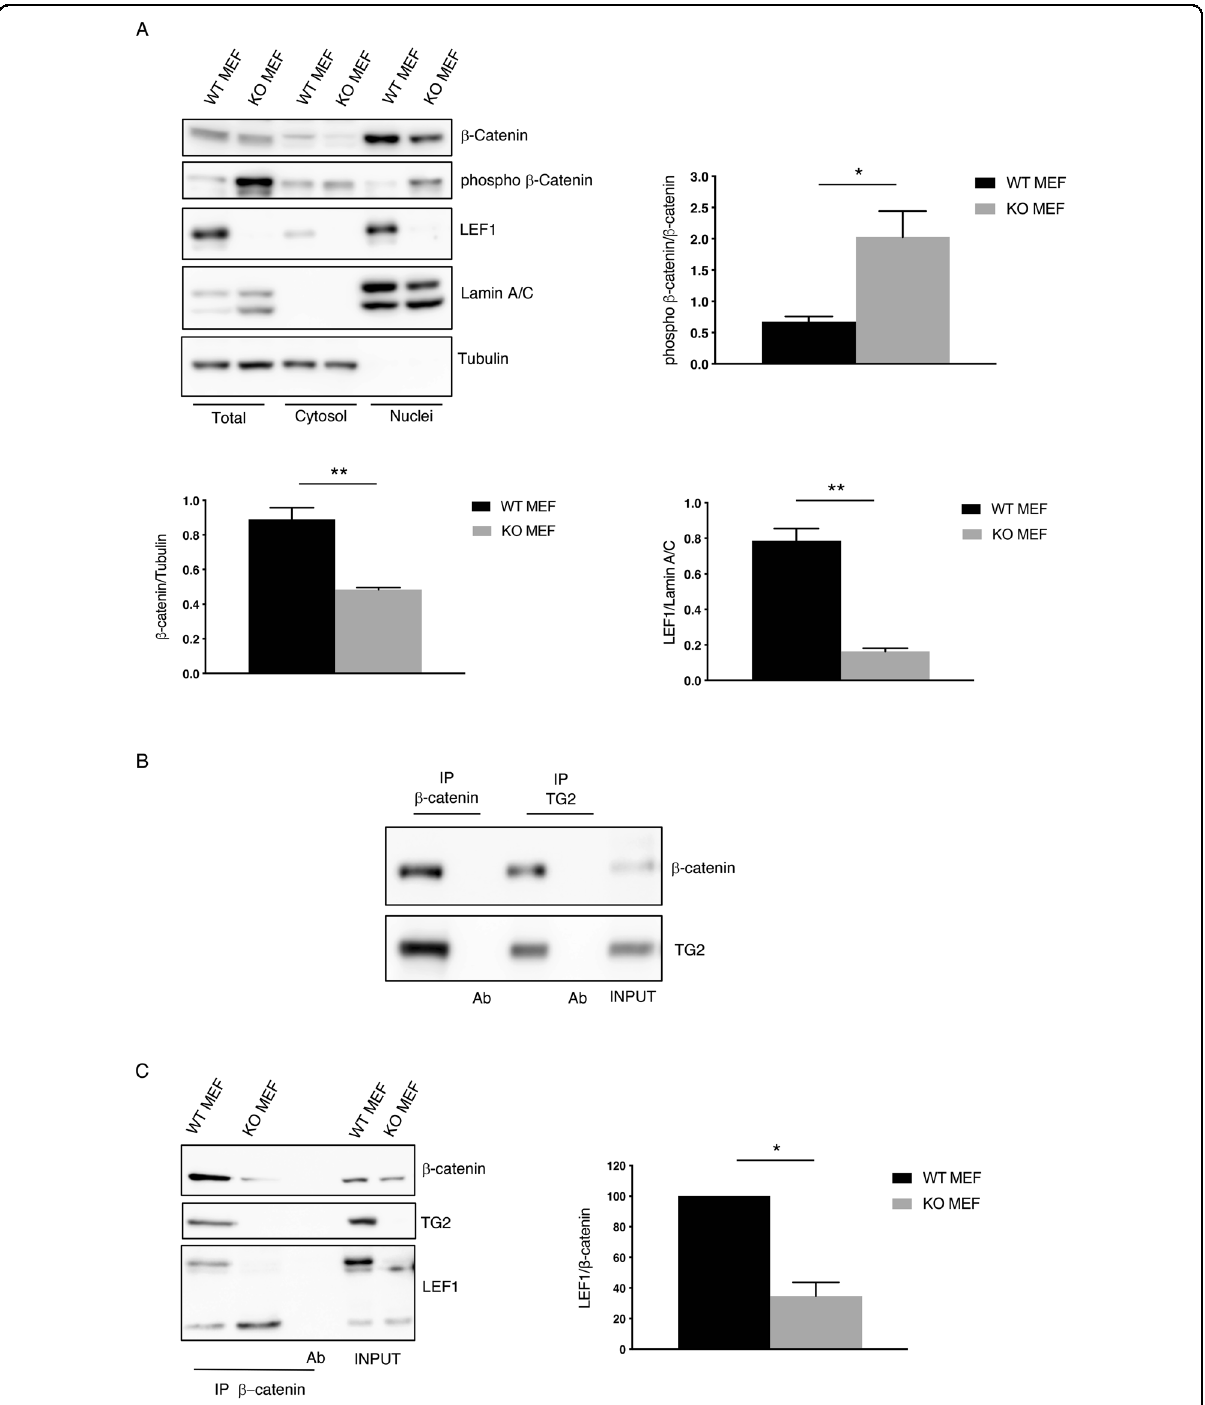
Fig. 3 TG2 regulates β -catenin transcriptional activity. A Representative western blot and densitometric analysis of β -catenin, its inhibitory phosphorylation, and LEF1 in total, cytosolic and nuclear fractions of WT and KO MEFs. Tubulin was used as loading control for cytosolic extract. Lamin A/C was used as loading control for nuclear extract. ( n = 3; means±SEM; * p <0.05; ** p <0.01). B Nuclear extract from WT MEFs was subjected to immunoprecipitation for β -catenin and TG2. Immuno- and co-immunoprecipitated proteins were separated by SDS-PAGE and blotted using the indicated antibodies. Input, total cell lysate was used as protein control. C Nuclear extracts, obtained from WT and KO MEFs, were subjected to immunoprecipitation for β -catenin. Immuno- and co-immunoprecipitated proteins were separated by SDS-PAGE and blotted using the indicated antibodies. Input, total cell lysate was used as protein control. Densitometric analysis of the ratio of co-immunoprecipitated LEF1/ β -catenin. ( n = 3; means±SEM; * p <0.05).